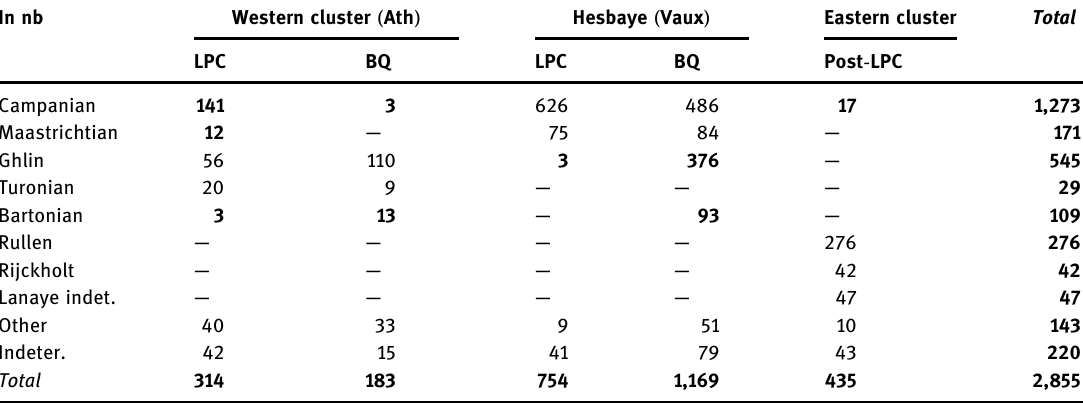
Table 1: Raw material identi fi ed on the studied blades from the three clusters In nb Western cluster ( Ath ) Hesbaye ( Vaux )